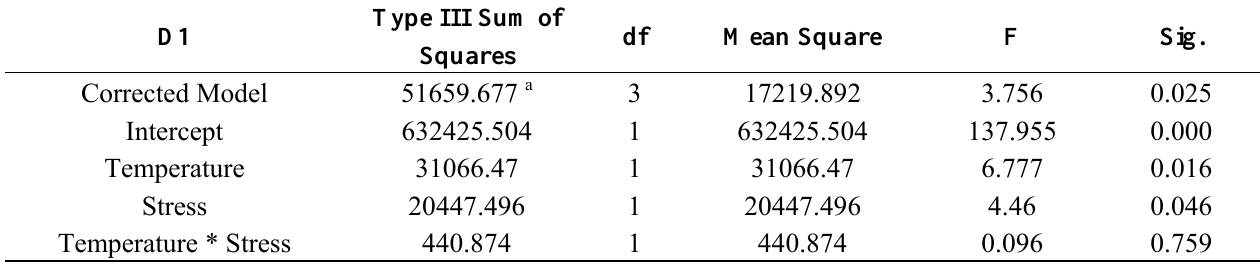
Table 2. Statistical analysis of the results (two-way ANOVA) to test the influence of temperature and water stress (independent variables) on the amount of diterpene in the leaves (dependent